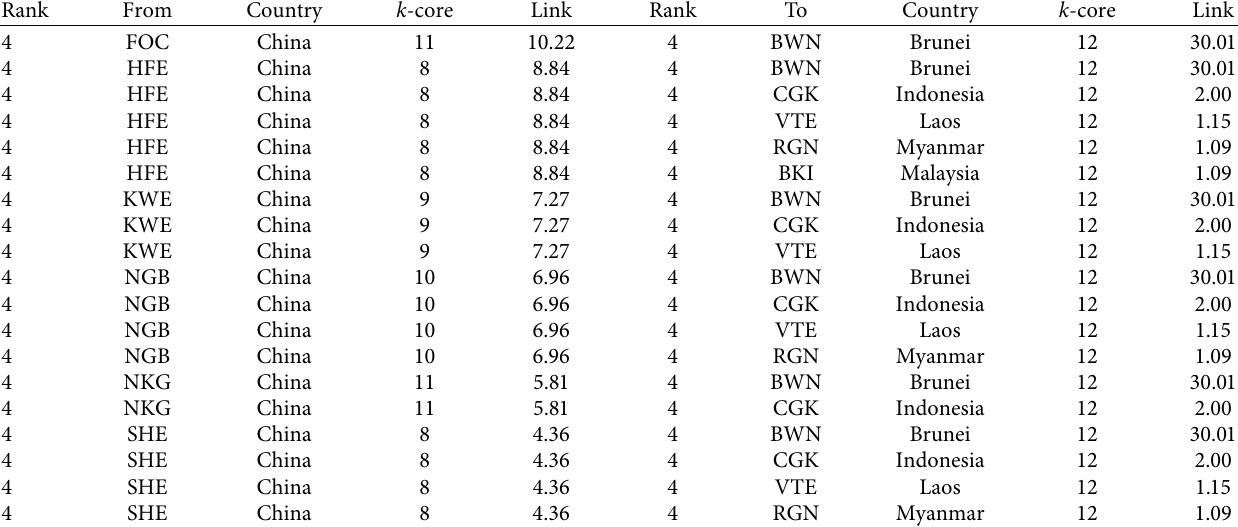
Table 6: Scheme 1 for deep integration into the key node set of the same community. Rank